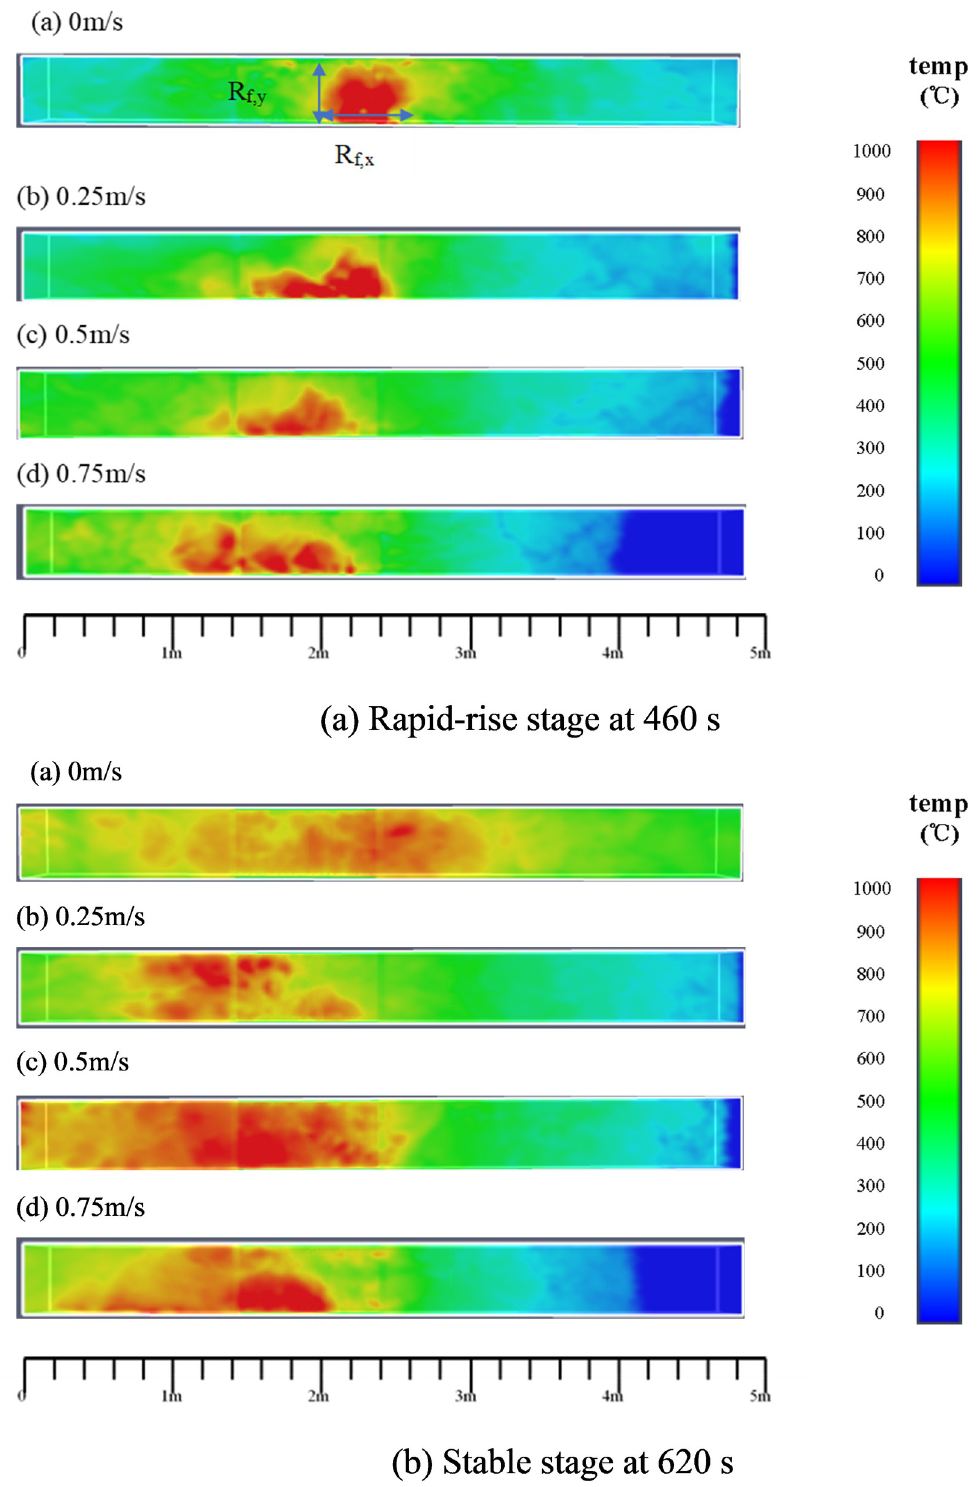
Fig 12. Ceiling temperature field of timber-lining fire at different wind speeds (z = 0.48 m).